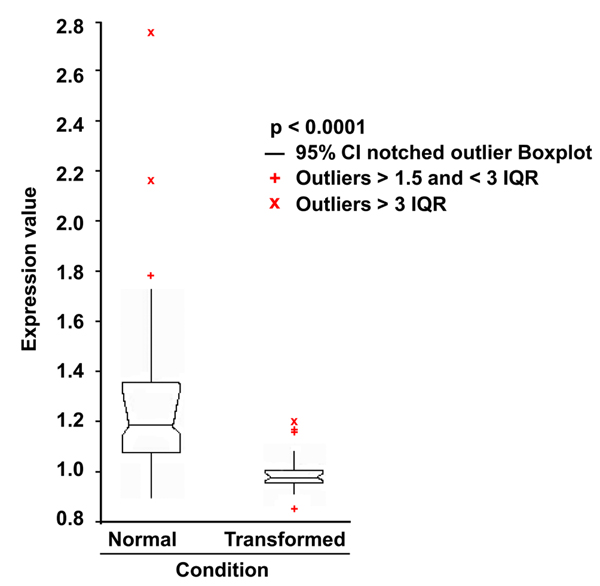
Statistical analysis of the 41 PKA pathway-encoding genes expression in normal and transformed samples. 81 transcriptional profiles from normal tissues and from the NCI60 cancer cell line collection, were recovered from the GEO database. After normalization (see Methods), the expression values of 41 PKA pathway-encoding genes were used to perform an ANOVA analysis (p-value 0.0001) to evaluate the statistical significance of the differences between normal and transformed samples. IQR: Interquartile Range. Outliers are also shown.